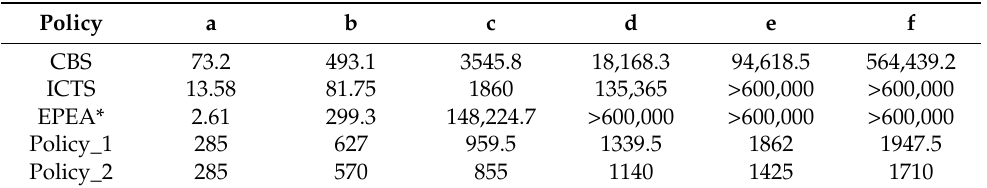
Figure 7. Robot trajectories using Policy_2 to guide the robot to complete the task in Figure 6a. Table 4. Time consumption, in milliseconds (ms). CBS, Conflict-Based Search; ICTS, Increasing Cost Tree Search; EPEA*, Enhanced Partial Expansion A*.